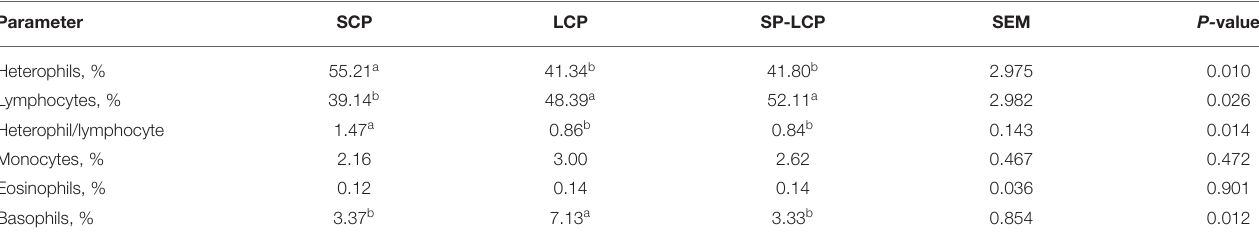
TABLE 3 | Effects of a standard corn/soy (SCP), low crude protein (LCP), and Spirulina included low crude protein diet (SP-LCP) on blood lymphocyte profiles of broilers on d 37. Parameter